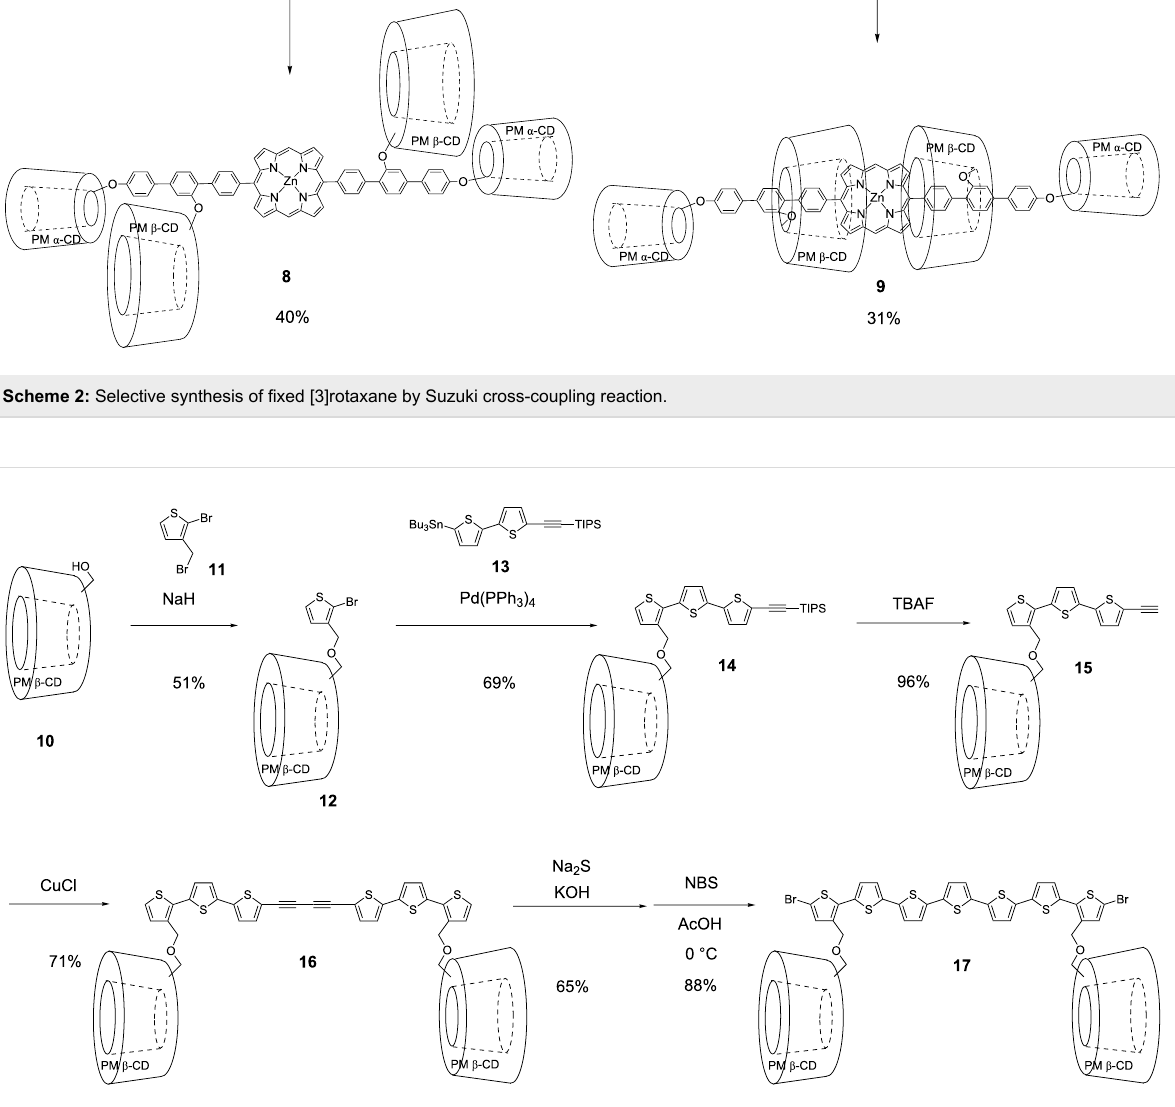
Scheme 3: The synthetic routes to precursor of PM β -CD based insulated